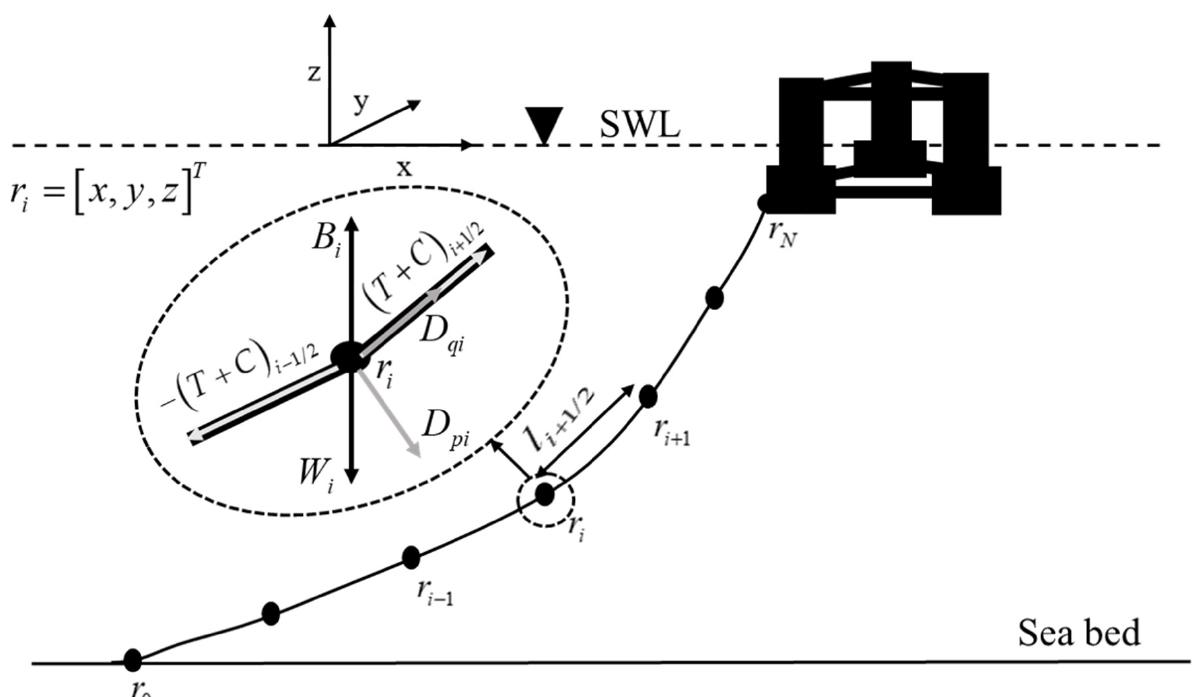
Figure 9. The schematic diagram of the mooring model.